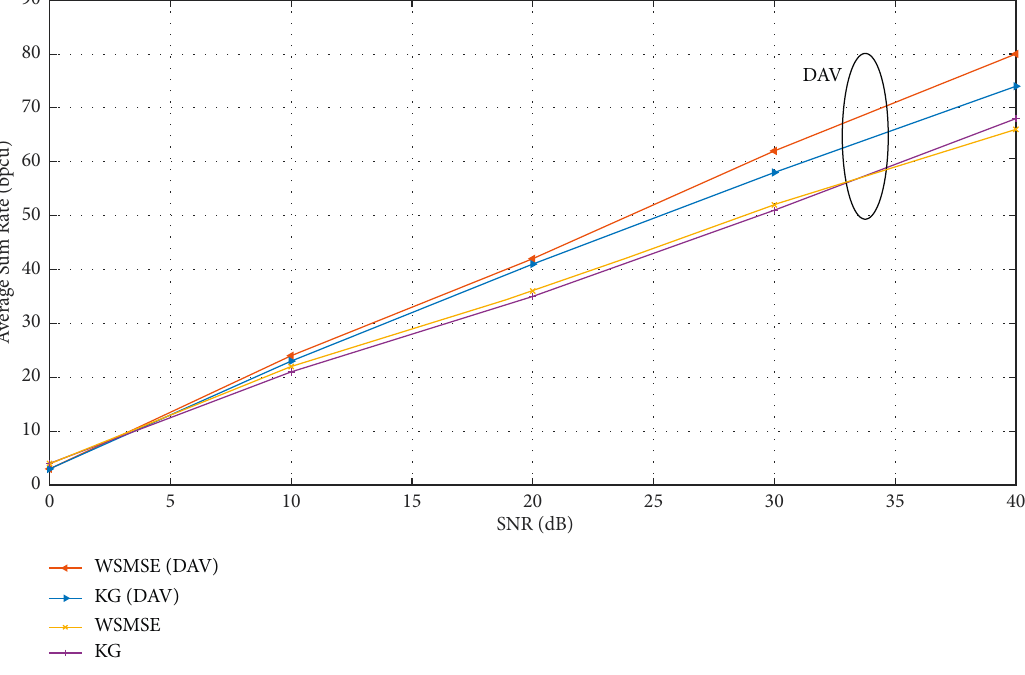
Figure 4: WSR in terms of SNR: C � 5 , K � 6 , M � 5, and N � 5.